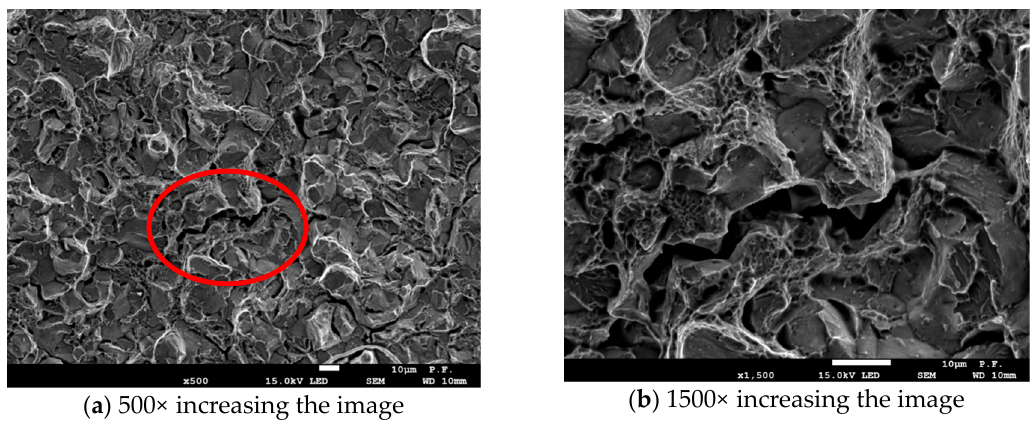
Figure 4. Morphology of the fracture surface the SENB specimen breakthrough: ( a ) general character of fracture surface; and ( b ) details of fracture mechanisms.